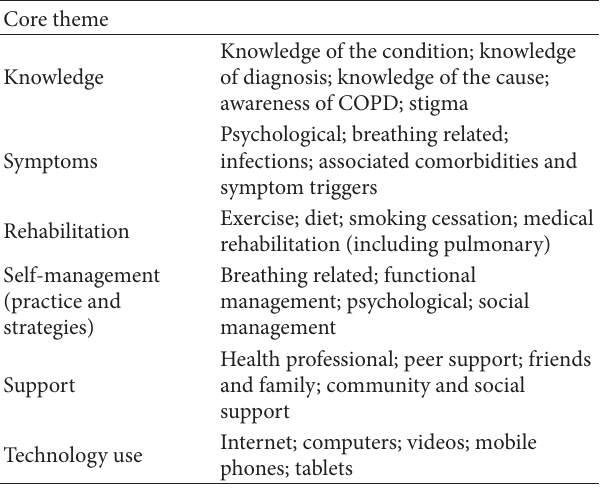
Table 2: Six core categories and